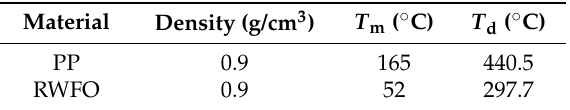
Table 3. Chairacteristic of binder and pure components ( T m and T d are melting temperature and decomposition temperature respectively).